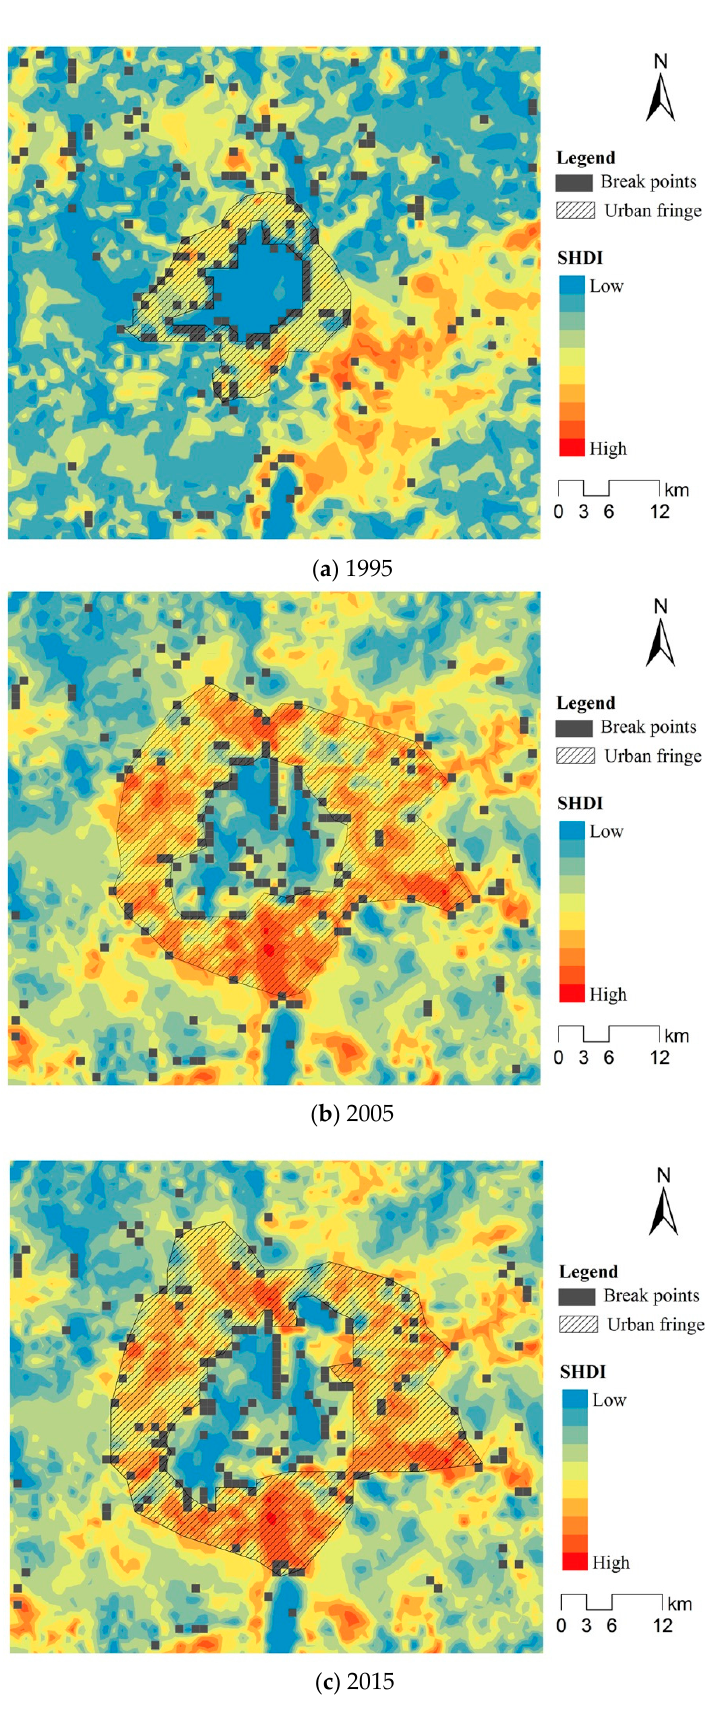
Figure 6. ( a – c ) Distribution of urban fringes (1995–2015). Table 4. Quantitative status of the expansion in the urban fringe of Changchun (1995–2015). Urban Core Area Urban Fringe